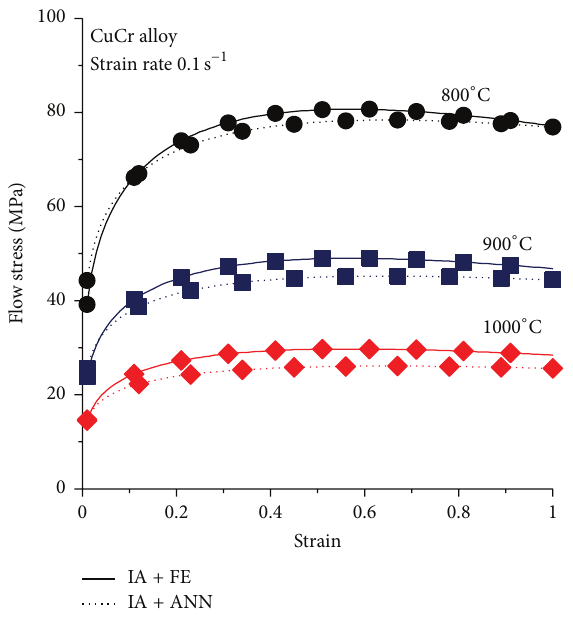
Figure 12: Flow stress calculated from (3) with coefficients obtained from the conventional IA + FE approach (solid lines) and inverse analysis with metamodel (dotted lines) for CuCr alloy, strain rate 0.1s −1 .